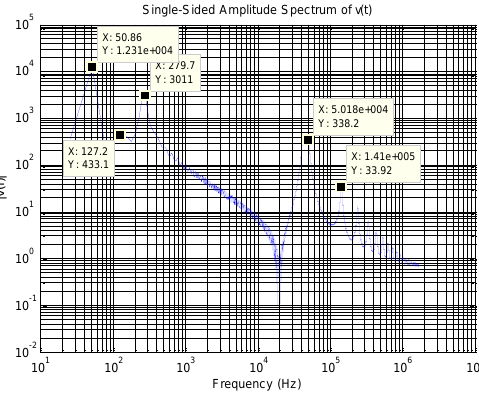
Fig. 23. FFT analysis for phase-c secondary voltage